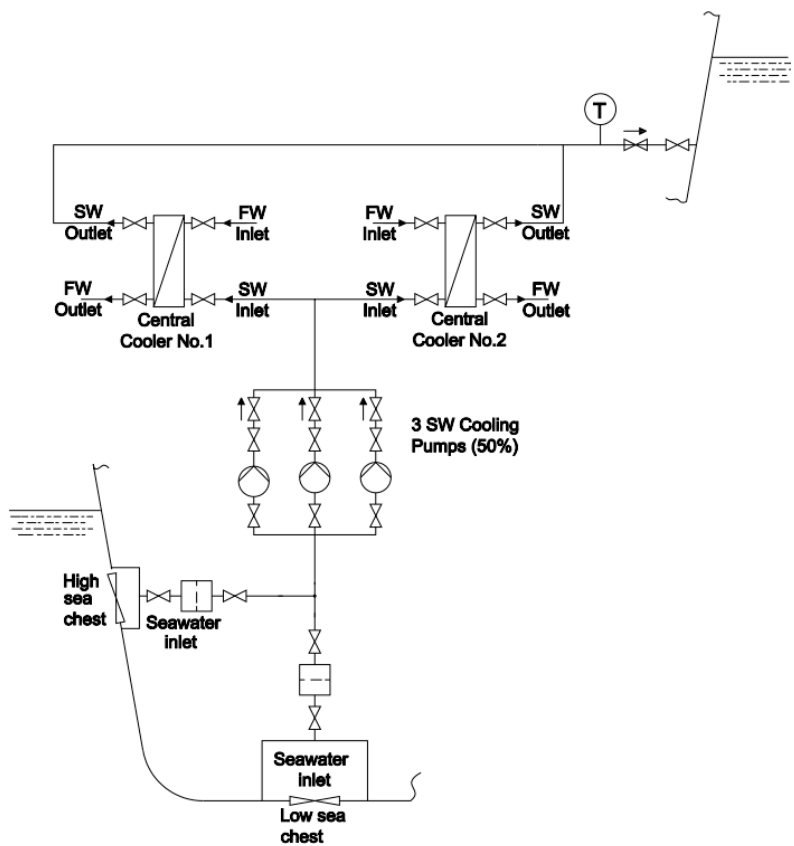
Figure 3. Typical seawater (SW) cooling system design used in handy-size bulk carriers.